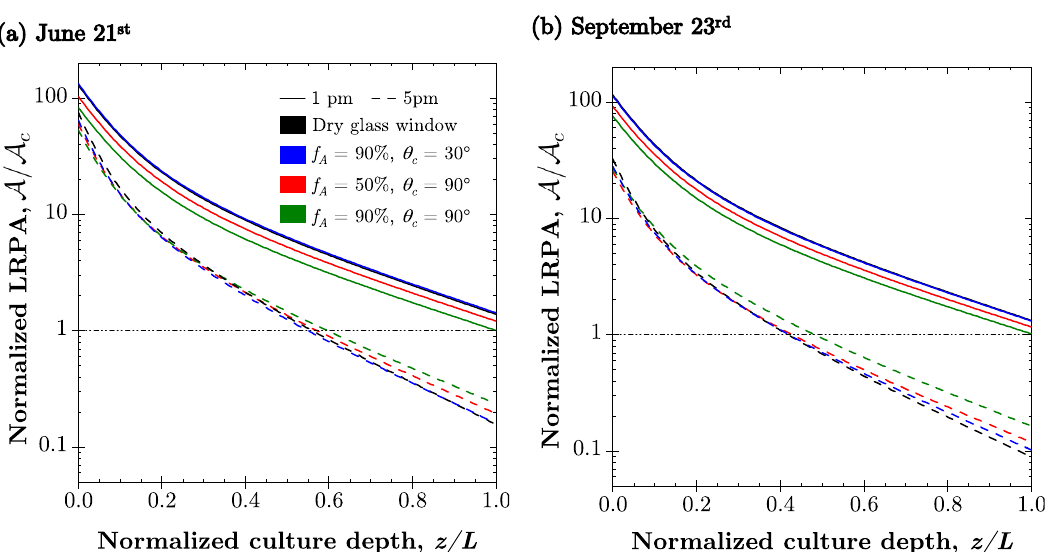
Figure 6. Normalized local rate of photon absorption (LRPA) A / A c as a function of the normalized culture depth z / L at 1 p.m. and 5 p.m. for a variety of window conditions on ( a ) 21 June and ( b ) 23 September in Los Angeles, CA. Here, L = 0.3 and A c = 2800 µ mol h ν kg − 1 s − 1